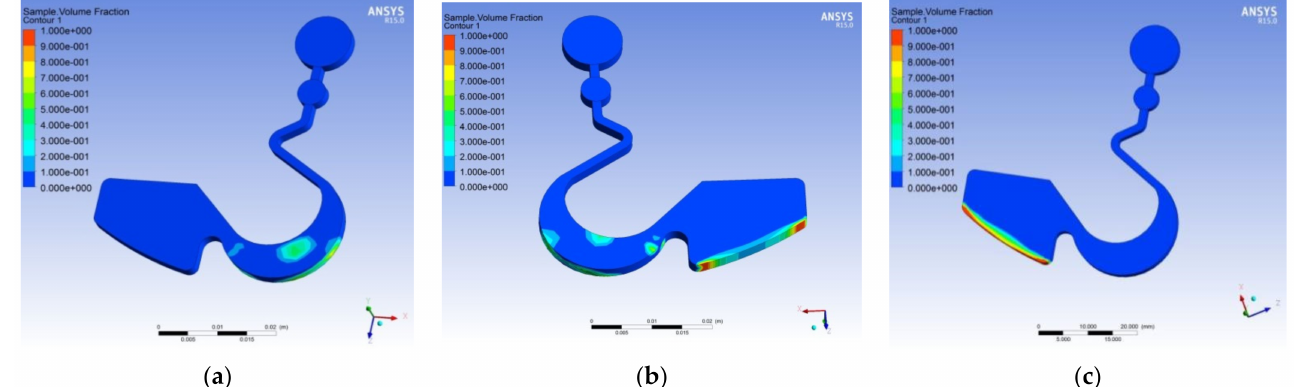
Figure 5. Optimal pattern design and simulation results of the disc. ( a ) The simulation result of the microfluidic flow after the disc spun at the first setting mode at a rotating speed of 100 rpm. ( b ) The simulation result of the microfluidic flow after the disc spun at the first setting mode at a rotating speed of 200 rpm. ( c ) The simulation result of the microfluidic flow after the disc spun at the second setting mode at a rotating speed of 250